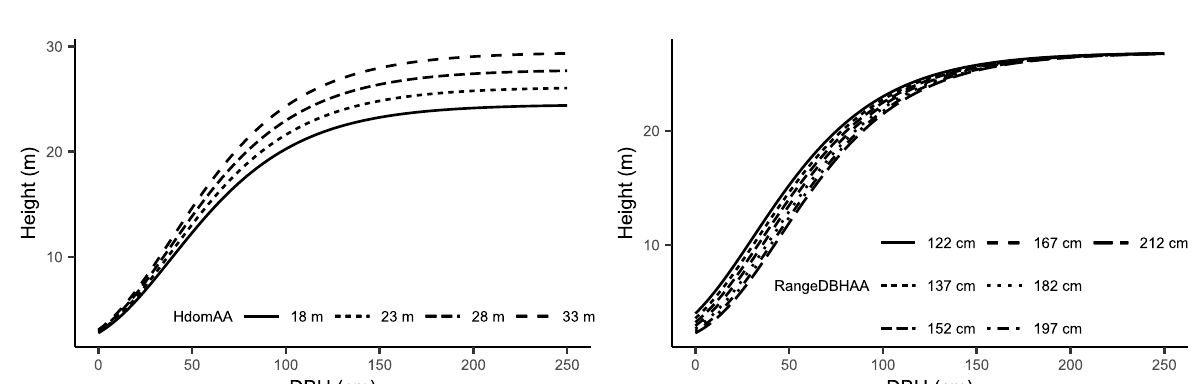
Fig. 5 Effects of dominant height of A. araucana ( H dom AA ) and the difference between the diameters at breast height of A. araucana ( RangeDBHAA ) on the height-diameter relationships of A. araucana . The curves were produced from the parameter estimates obtained when fitting Eq. 1. The values of the stand variables were replaced using the mean value except for the stand variable of interest, which slowly varied from the minimum to the maximum at the same spacing